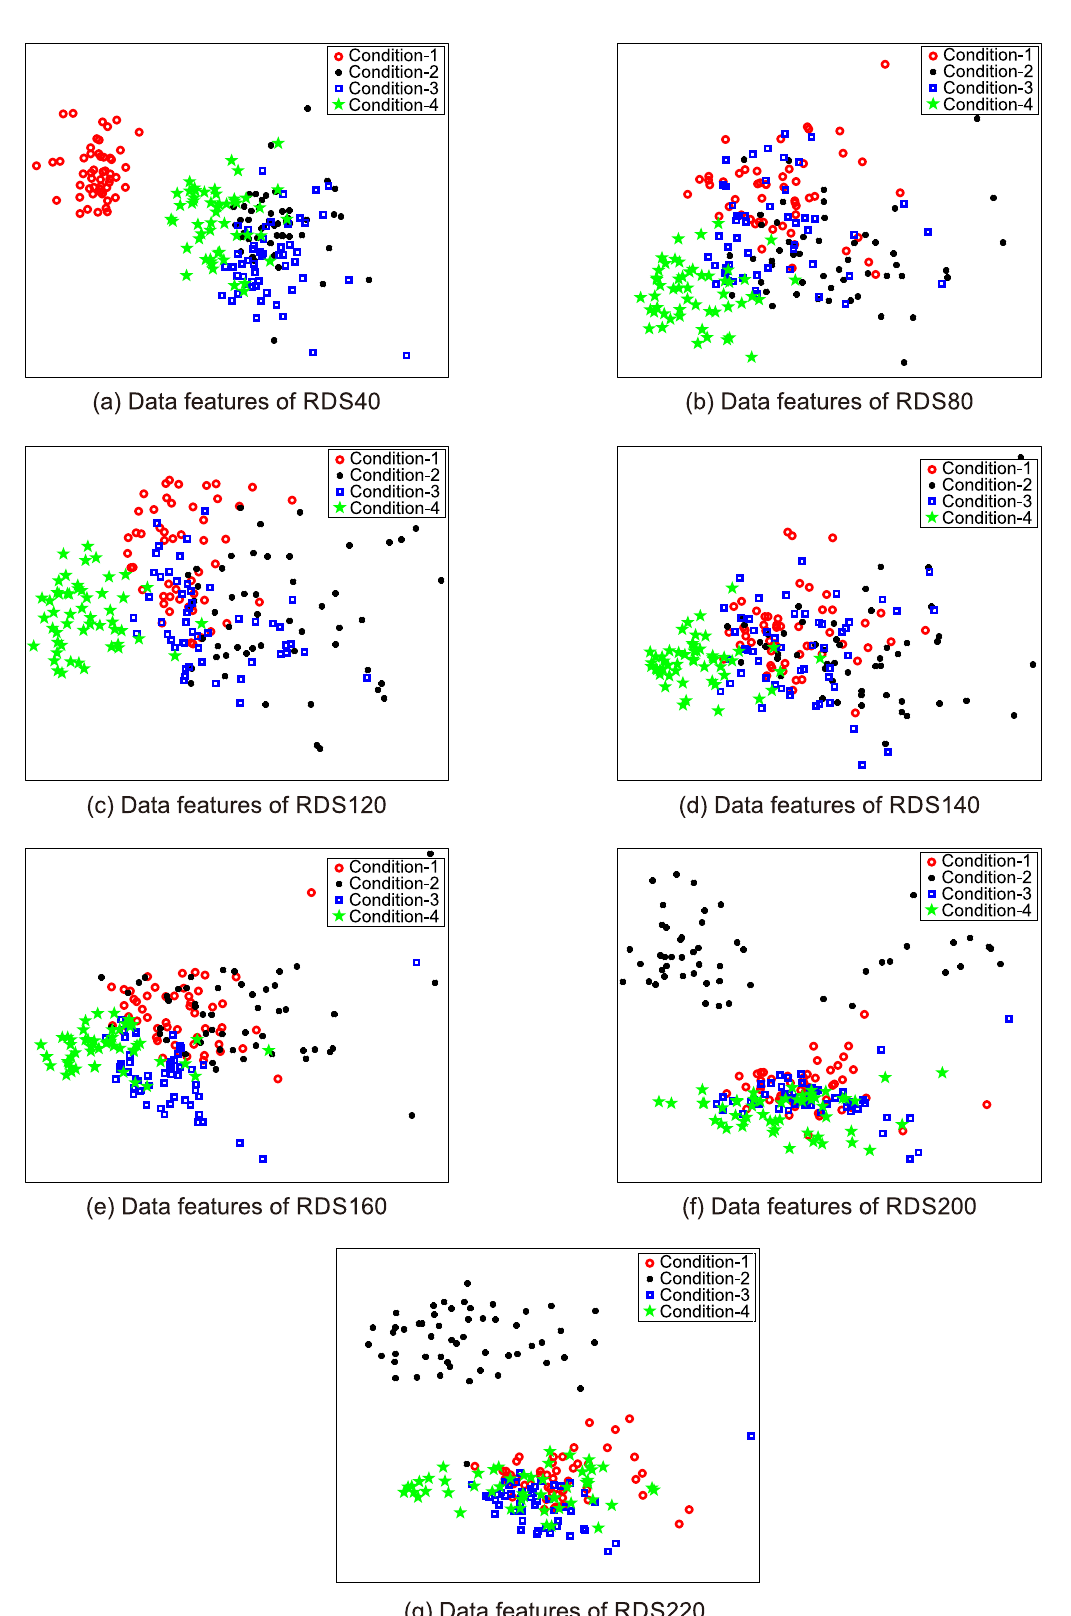
Fig. 4 Data features of four conditions at different